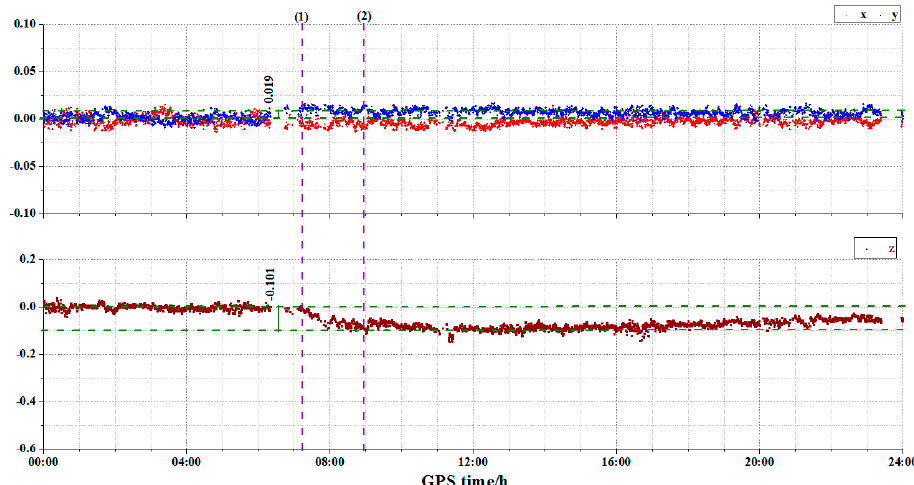
Figure 21. Real-time tower deflection of QDKZ. The vertical line ( 1 ) represents the start point of saddle pushing and ( 2 ) represents the end point of saddle pushing. The deformation of the x-direction is shown in red, the y-direction is shown in blue and z is shown in wine. Table 10. The deformation error between multi-GNSS and RTS